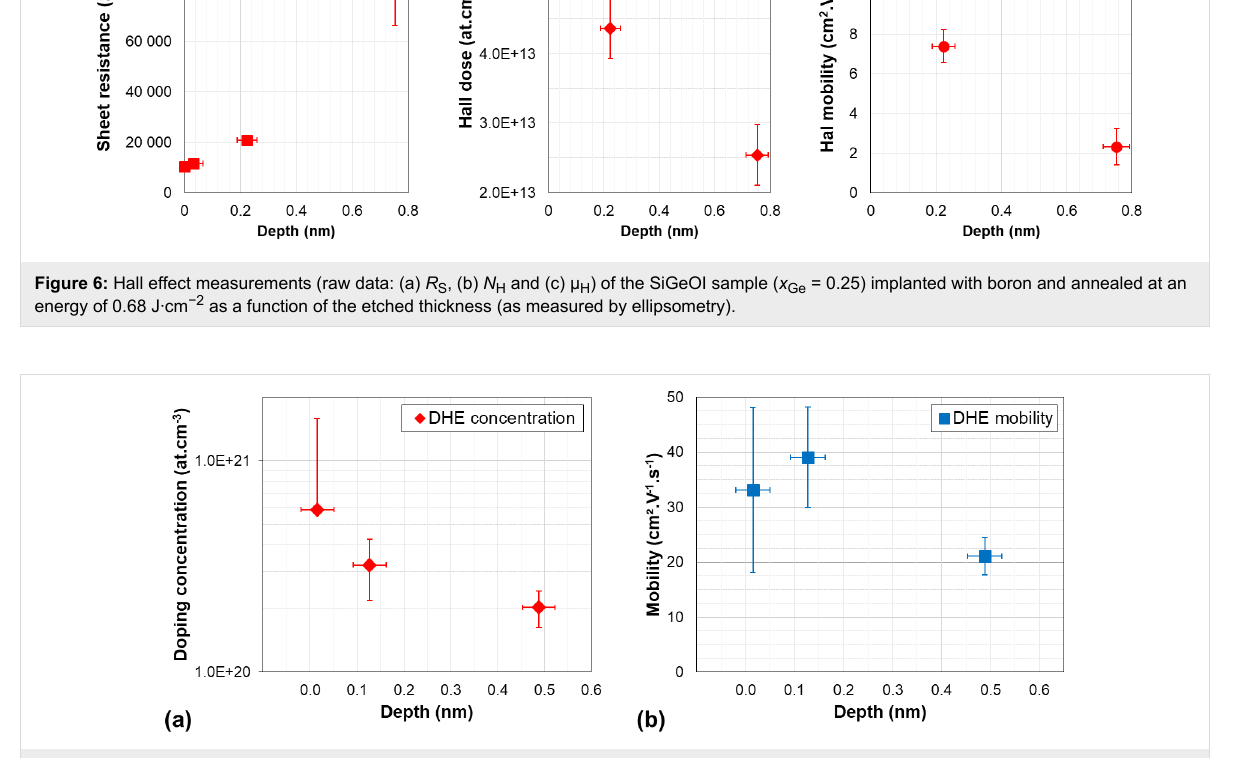
Figure 7: Depth profiles of (a) active dopant concentration and (b) carrier mobility extracted from DHE measurements of a SiGeOI sample ( x Ge = 0.25) implanted with boron and annealed at an energy of 0.68 J·cm − 2